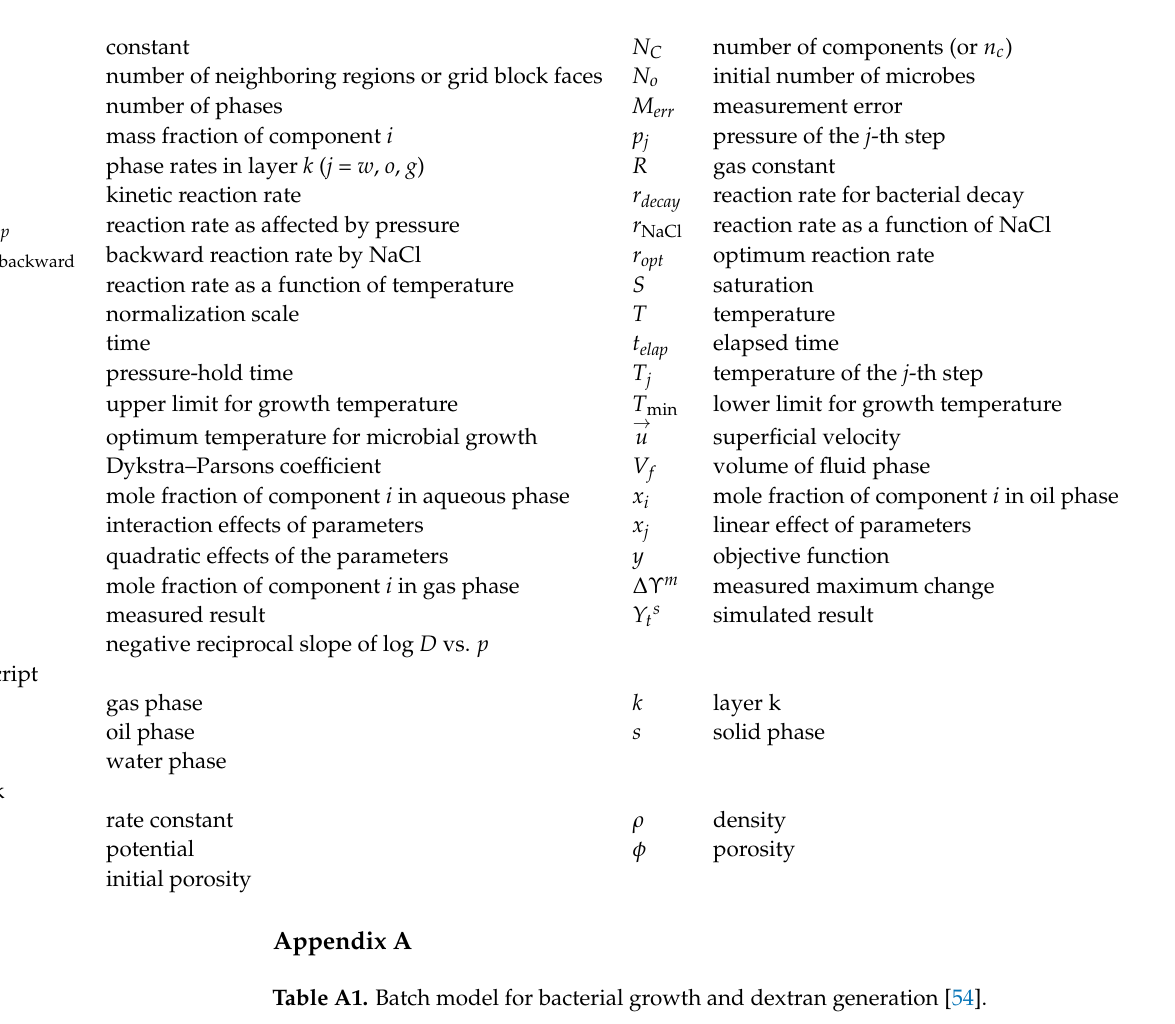
Table A1. Batch model for bacterial growth and dextran generation [54]. Growth Media Composition (Mole Fraction)